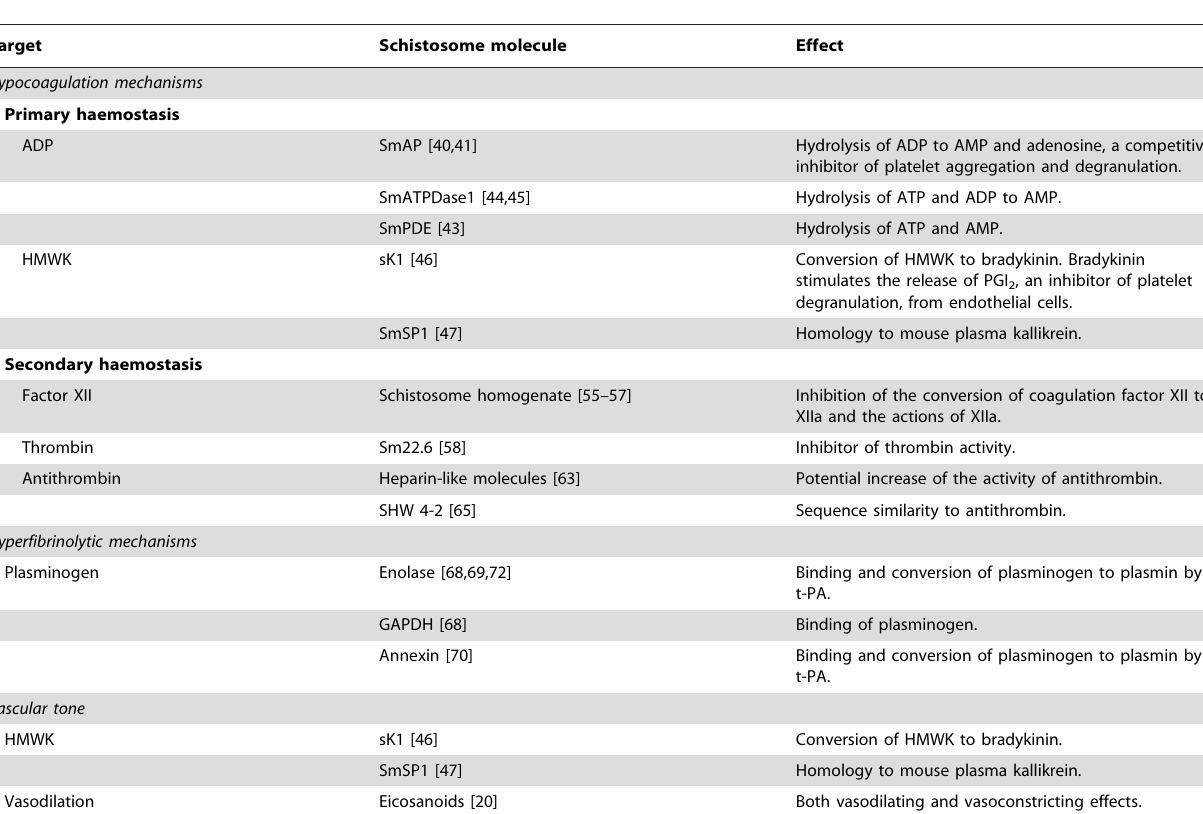
Table 1. Proposed interference with the haemostatic system and vascular tone by schistosome